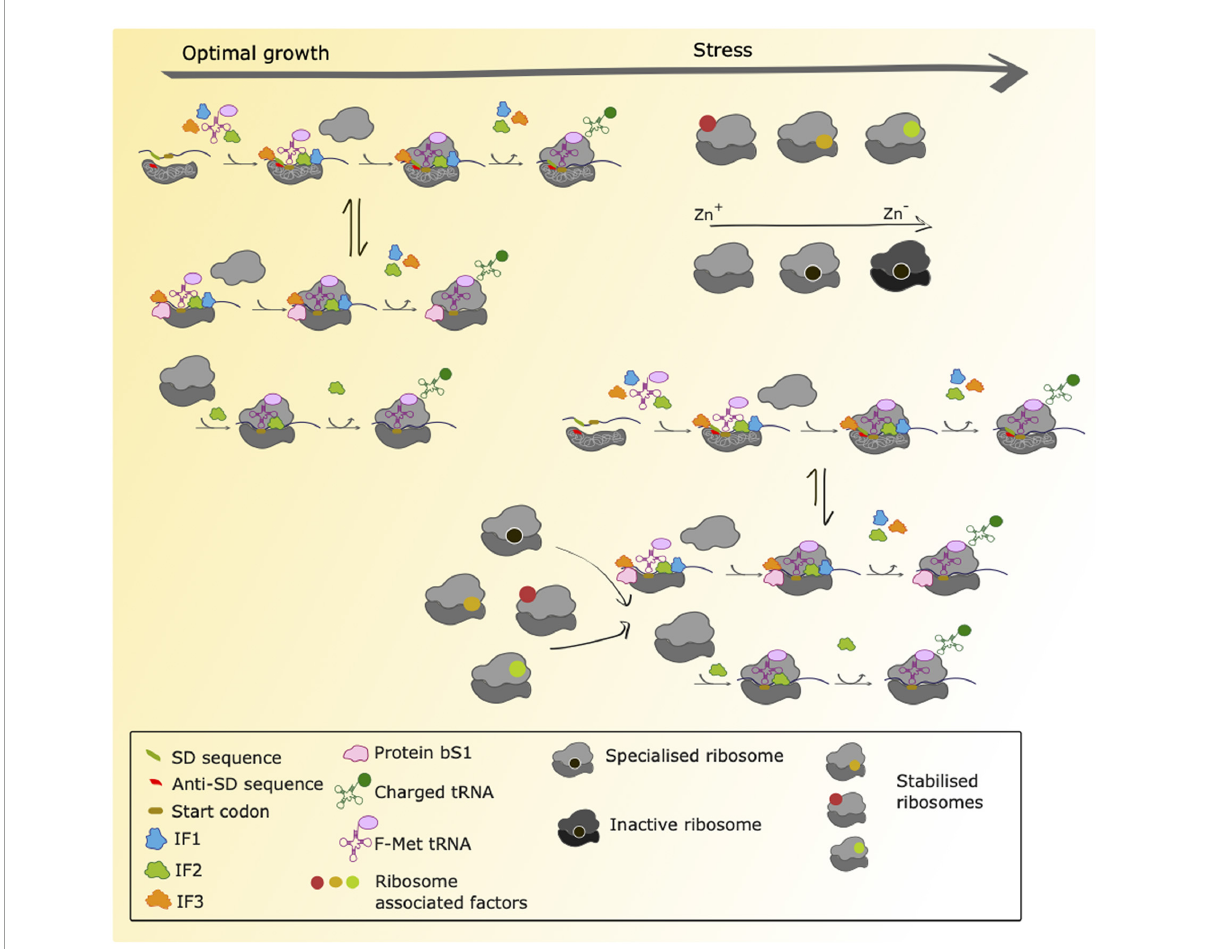
FIGURE2 Proposed scenarios for translation initiation in M. tuberculosis during normal growth and stress adaptation. During conditions of normal growth, M. tuberculosis uses both canonical initiation mechanisms (SD-aSD interaction) as well as alternative initiation mechanisms that are still uncharacterized. These could involve ribosomal protein bS1 to initiate translation of transcripts lacking a strong SD sequence within the 5 (cid:48) UTR and 70S-mediated initiation of transcripts lacking a 5 (cid:48) UTR as previously characterized in E. coli . Ribosome profiling studies have shown that both canonical and non-canonical transcripts are robustly translated in M. tuberculosis (Sawyer et al., 2021), suggesting that mechanisms for canonical and non-canonical translation initiation are in place and that there is an equilibrium between both (represented with the arrows in the Figure). During conditions of stress there are ribosome associated factors that could bind with ribosomes to stabilize them. Furthermore, it has been shown that during conditions of zinc deprivation, specialized ribosomes containing paralogs of ribosomal proteins are formed and are translationally active. As conditions of zinc depletion increase, these ribosomes become inactive. We hypothesize that during conditions of stress, M. tuberculosis temporarily relies on alternative initiation mechanisms to sustain protein synthesis, and that these mechanisms might be favored by specialized and/or stabilized